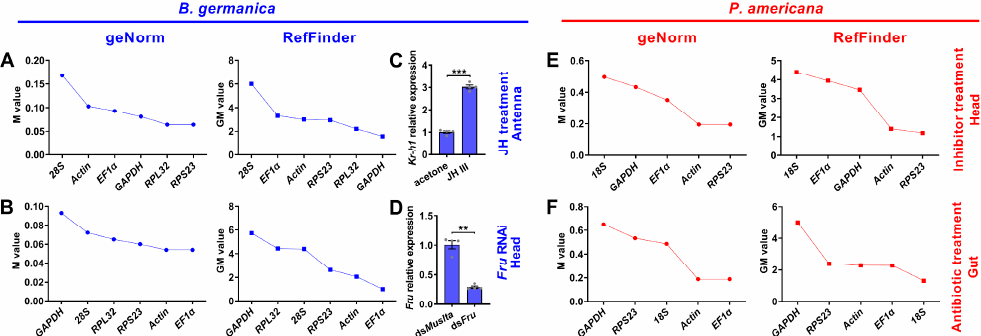
Figure 4. Expression stability rankings of candidate reference genes under experimental treatments. The M and GM values were calculated by the geNorm and RefFinder algorithms, respectively, for candidate reference genes under JH treatment ( A ) or RNAi condition ( B ) in B. germanica , and under inhibitor ( E ) or antibiotic ( F ) feeding condition in P. americana. Effects of JH and dsRNA treatment in B. germanica on the expression of Kr-h1 ( C , n = 4) and fru ( D , n = 4) expression, with normalization to GAPDH and EF1 α , respectively. ** p < 0.01, *** p < 0.001 ( Student’s t -test ).